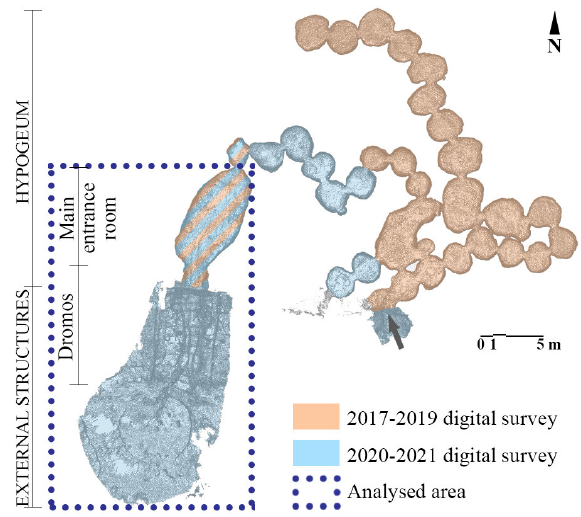
Figure 7 . Top view of the final laser scanner point cloud.